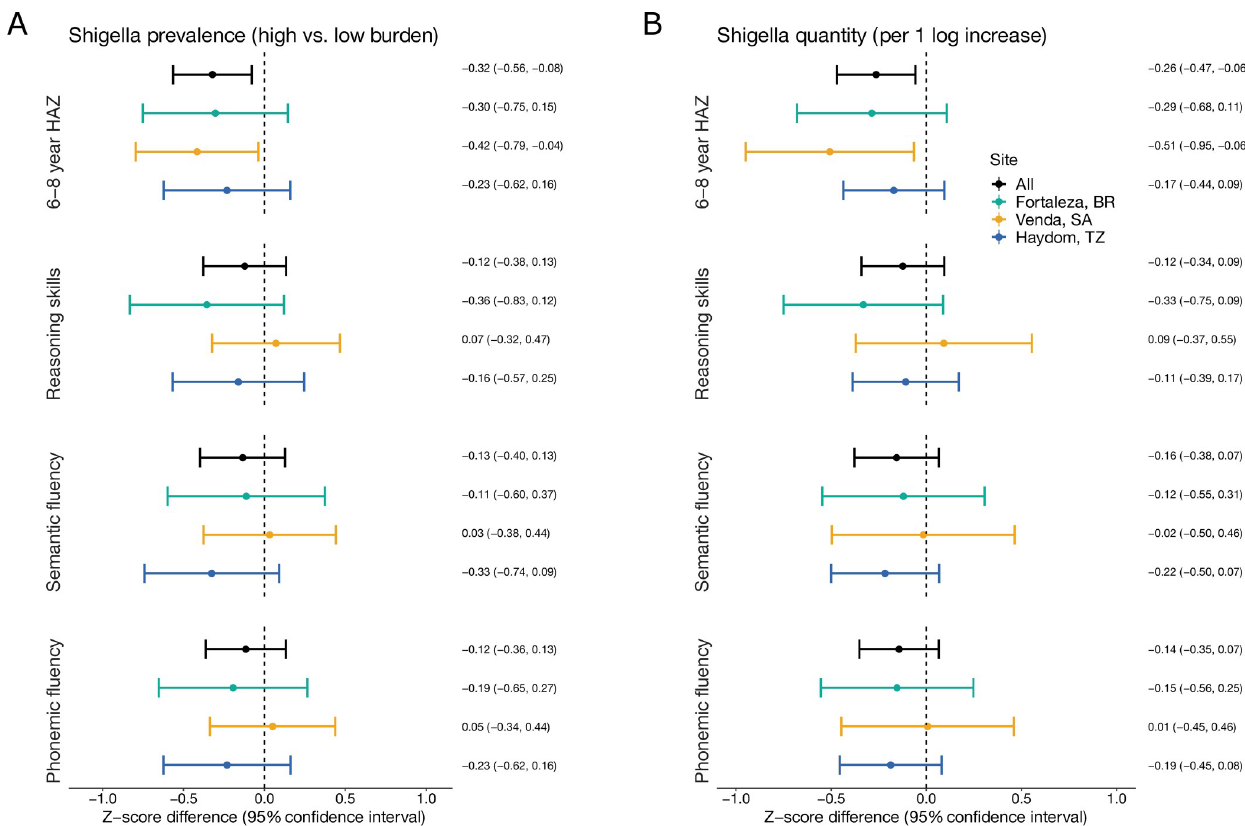
Fig 1. Associations between Shigella prevalence (A) and quantity (B) in the first 2 years of life with linear growth and cognitive outcomes at 6–8 years of age among 451 children in the Brazil, South Africa, and Tanzania MAL-ED cohorts. Mean Z-score difference estimates and 95% confidence intervals were derived from linear regression models adjusting for site, age at the 6–8 year assessment, enrollment weight-for-age z-score (or enrollment length-for-age z- score for height outcomes), sex, socioeconomic status, exclusive breastfeeding in the first 6 months, maternal height, and the burden of each of the 12 most prevalent pathogens identified in the first 2 years of life (excluding Shigella